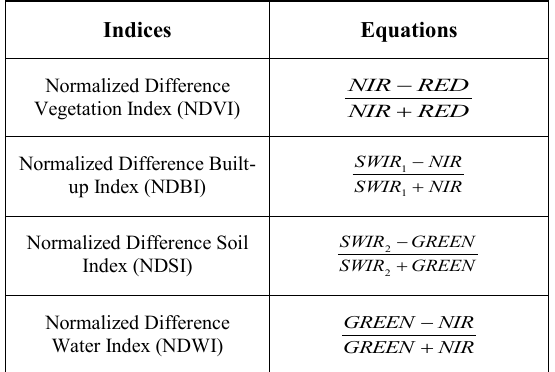
Figure1. Location map of study area Table1. Equations for estimating different